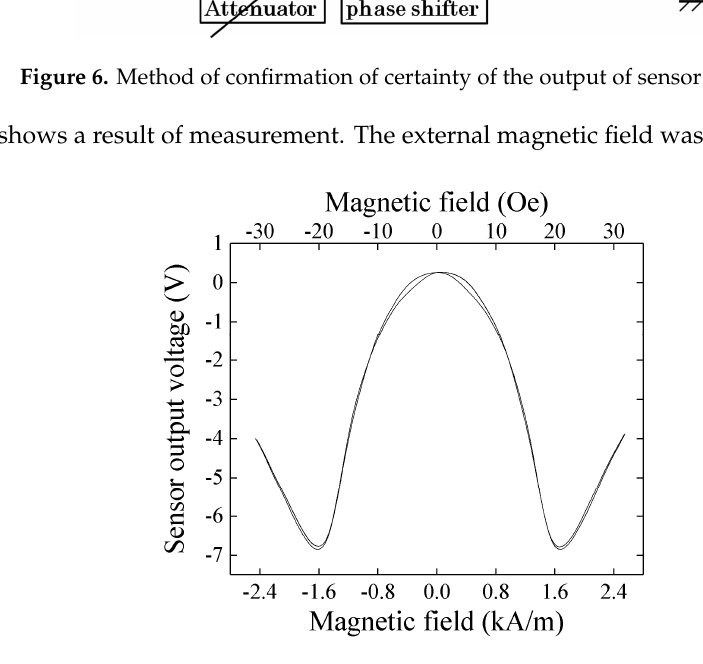
Figure 6. Method of confirmation of certainty of the output of sensor system.